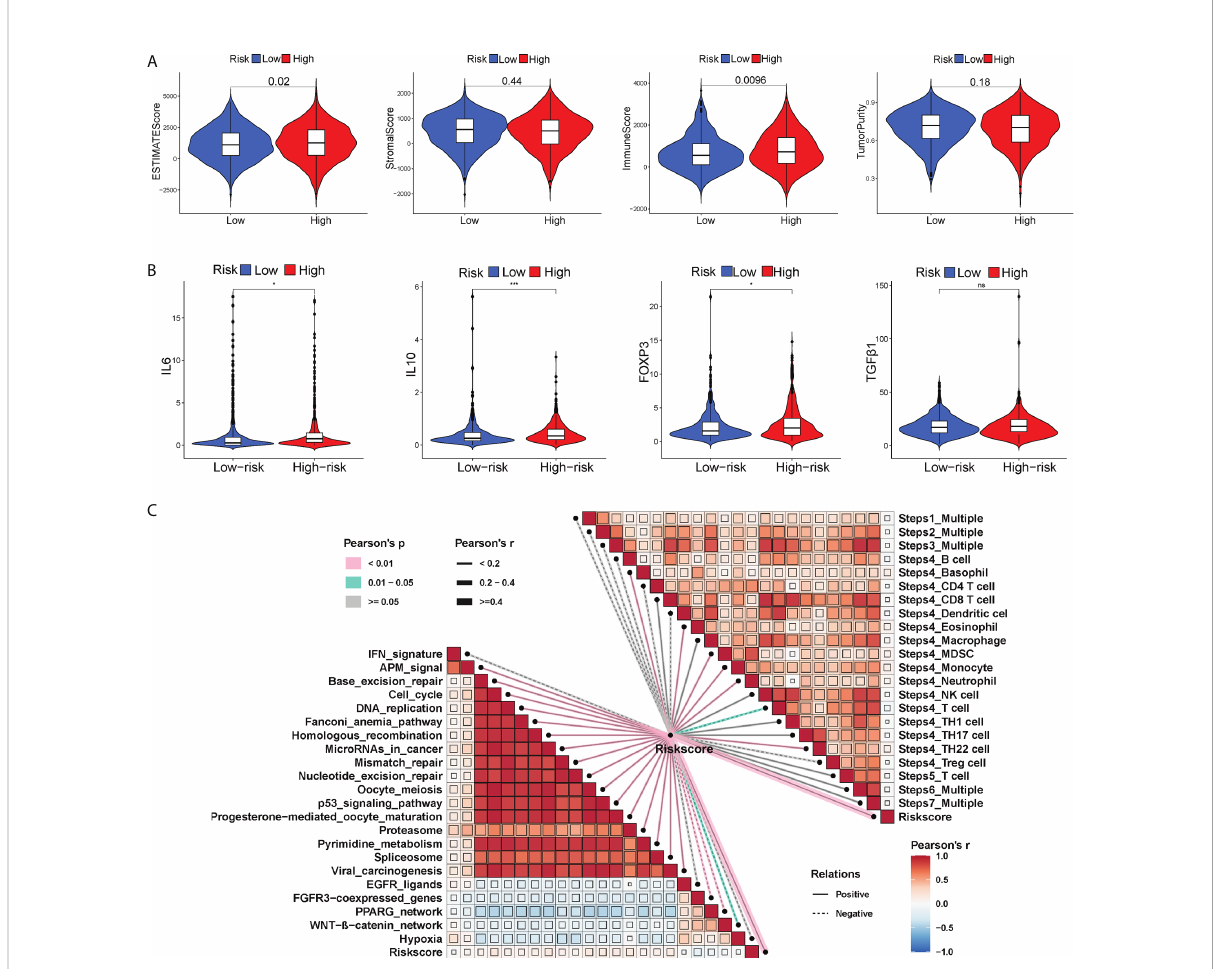
FIGURE 5 The differential immune activation between two risk subgroups. Violin plots of the ESTIMATE score, stromal score, immune score and tumor purity between two risk groups (A) . Violin plots showing the expression of immunosuppressive factors in the TME (IL6, IL10, FOXP3 and TGF- b ) between two risk groups (B) . (C) Correlation of the risk score with cancer-immunity cycle and some biological progress in BC progression. *P < 0.05; ***P < 0.001; ns, no signi fi